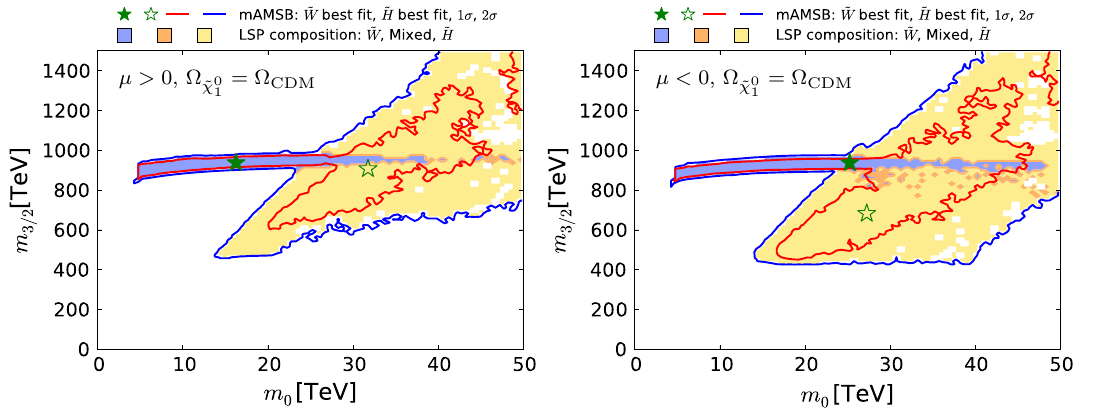
The wino-like (Higgsino-like) DM regions are shaded blue ( yel- low ), and mixed wino–Higgsino regions are shaded orange . The best-fit points for the two signs of μ are indicated by green stars , closed in the wino-like region and open in the Higgsino-like . 1